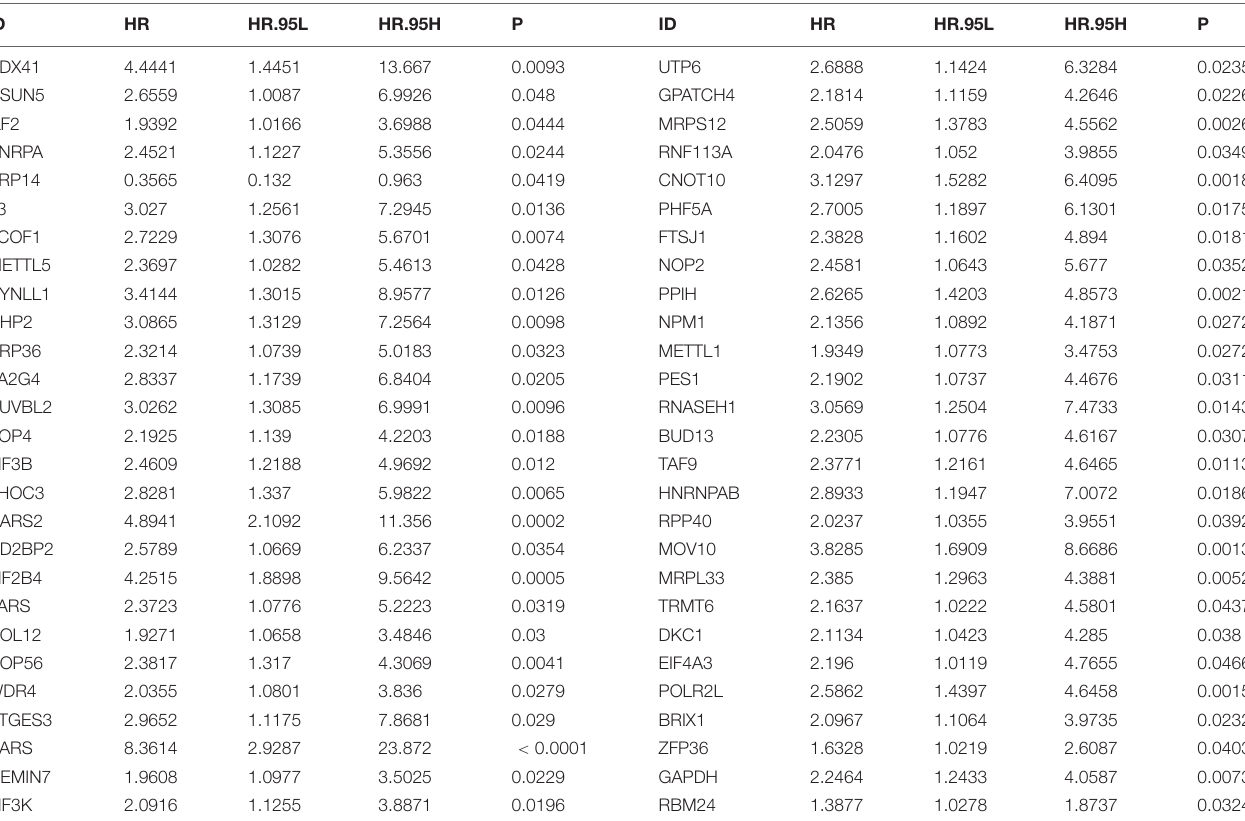
TABLE 3 | Prognosis-related RBPs in HBV-related HCC patients by univariate cox regression analysis.